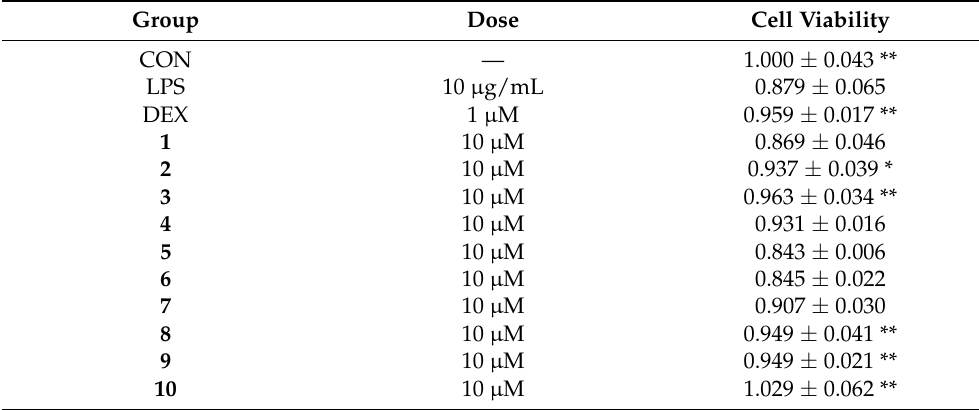
Table 2. The protective effect of compounds 1–25 on BEAS-2B cell injury induced by LPS.